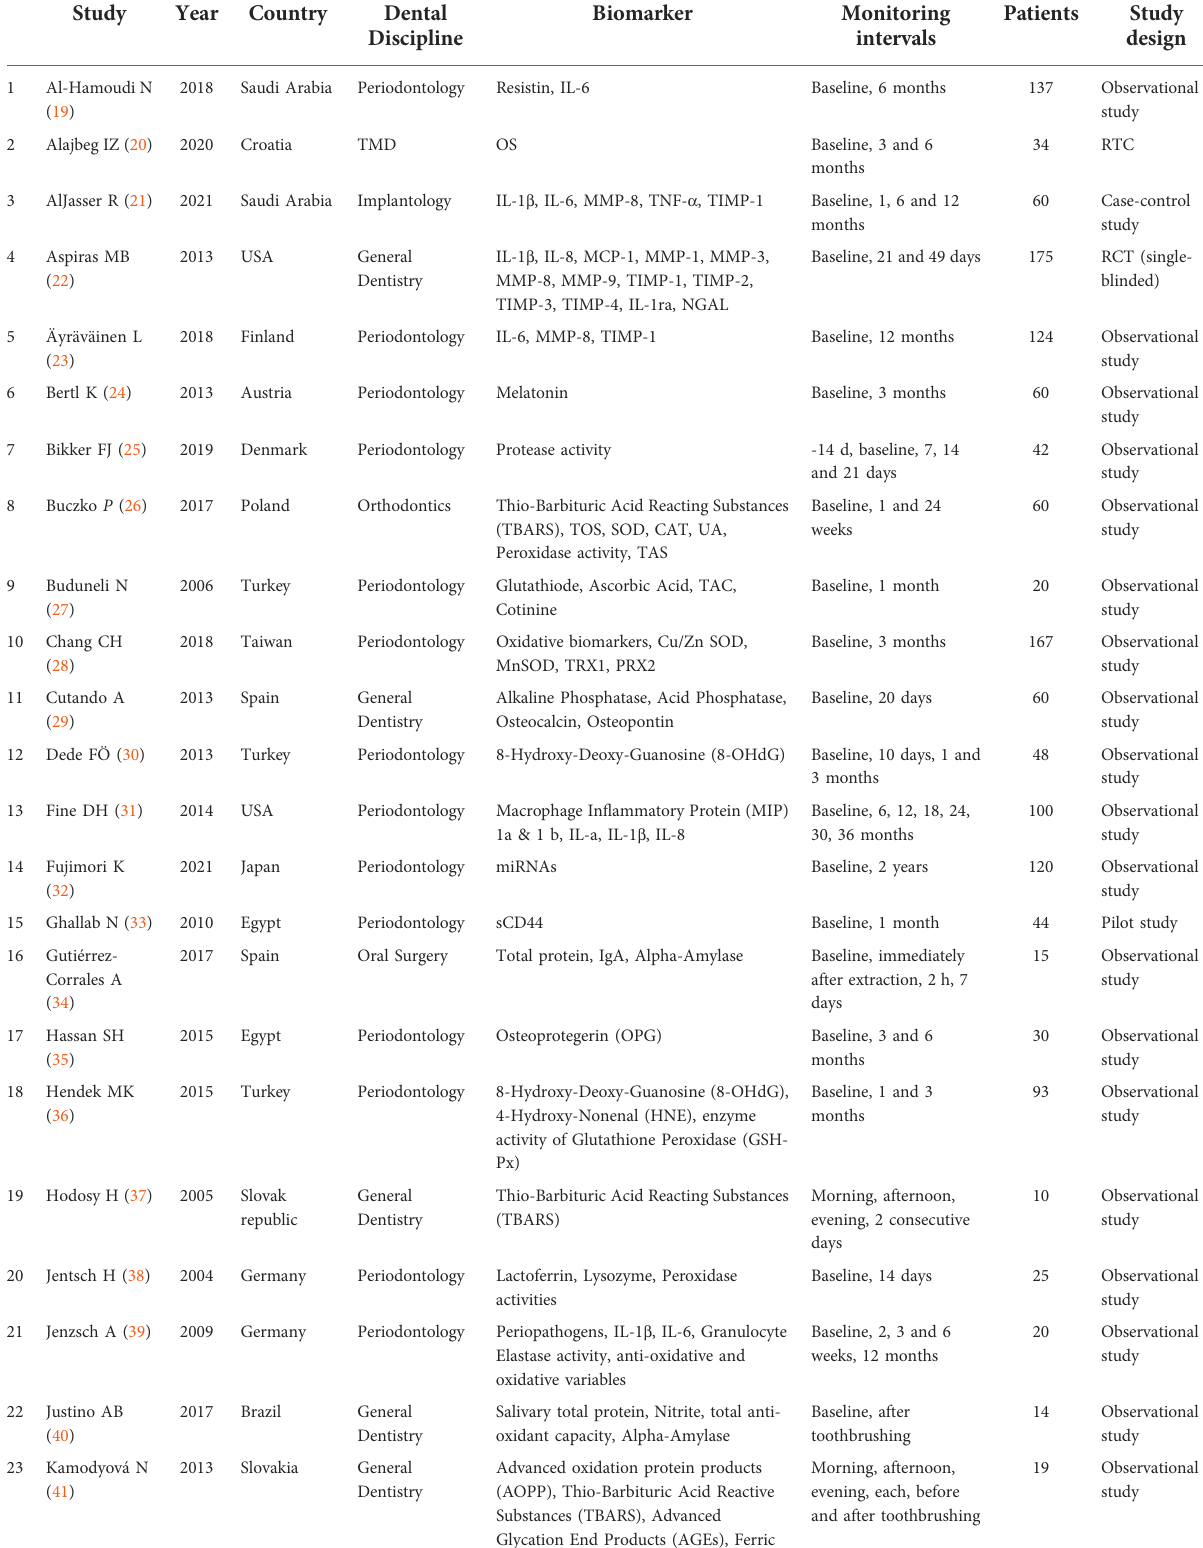
TABLE 1 Included studies with extracted data items.